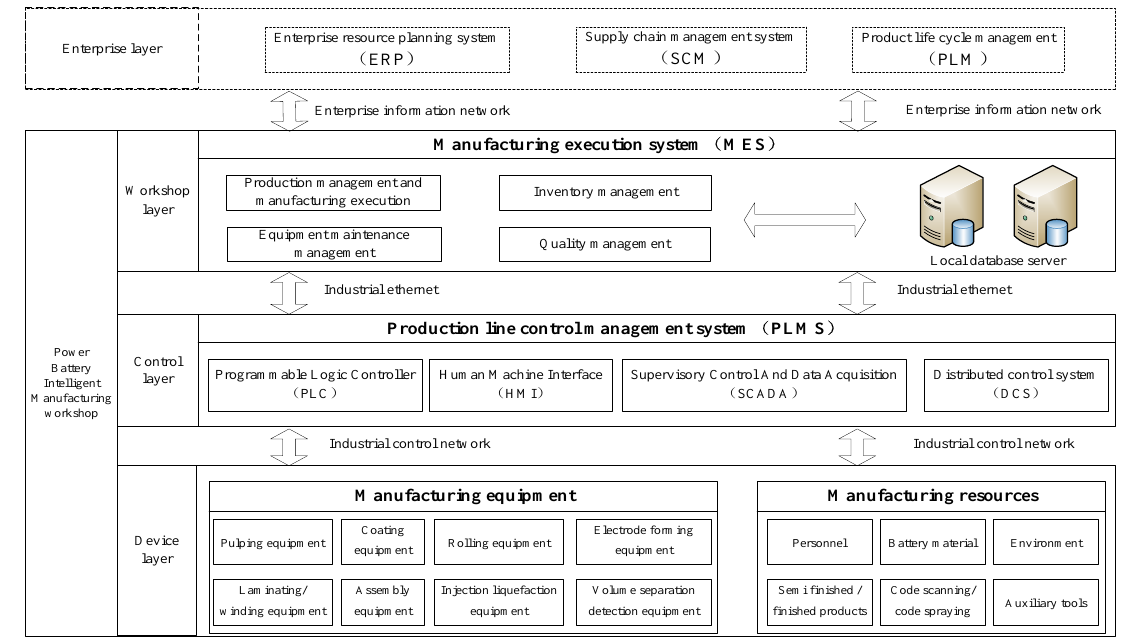
Figure 2. Organization structure schematic diagram of lithium ion battery intelligent manufacturing workshop.